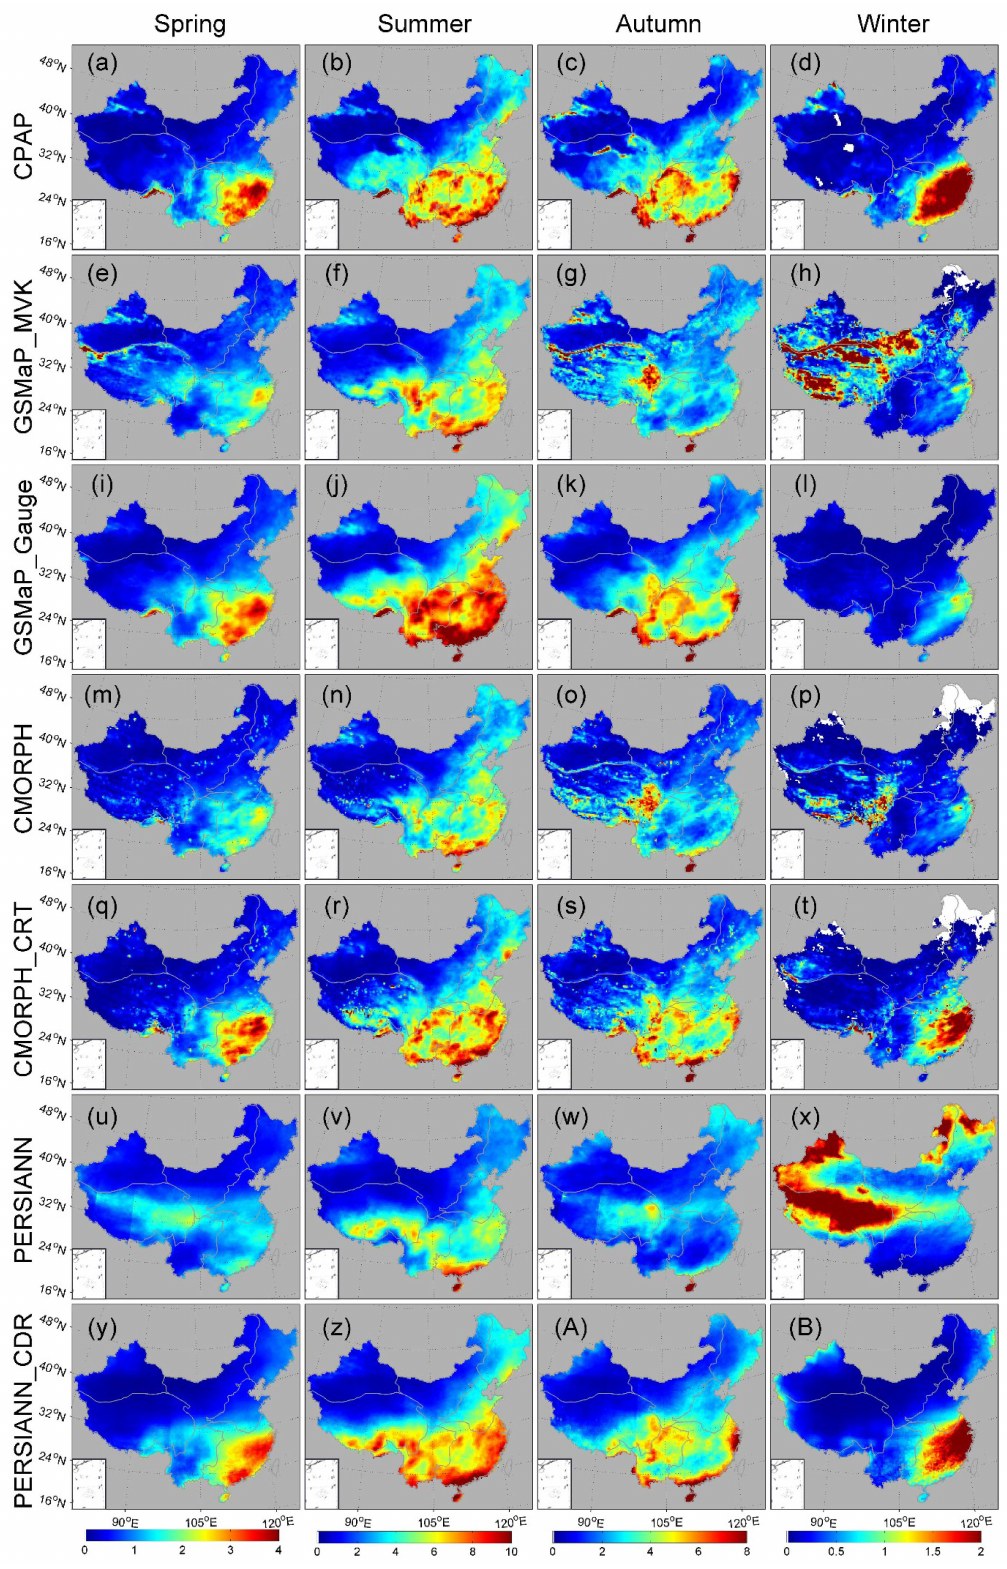
Figure 5. Seasonal four-year daily mean precipitation distribution over China for ( a – d ) CPAP; ( e – h ) GSMaP_MVK; ( i – l ) GSMaP_Gauge; ( m – p ) CMORPH; ( q – t ) CMORPH_CRT; ( u – x ) PERSIANN; and ( y – B )